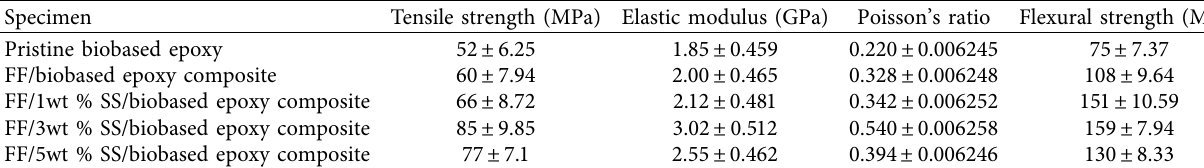
Table 1: Measured mechanical properties of modified and unmodified biobased